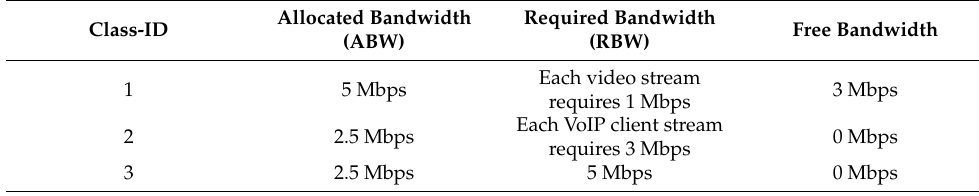
Table 6. Scenario 1 Adaptation